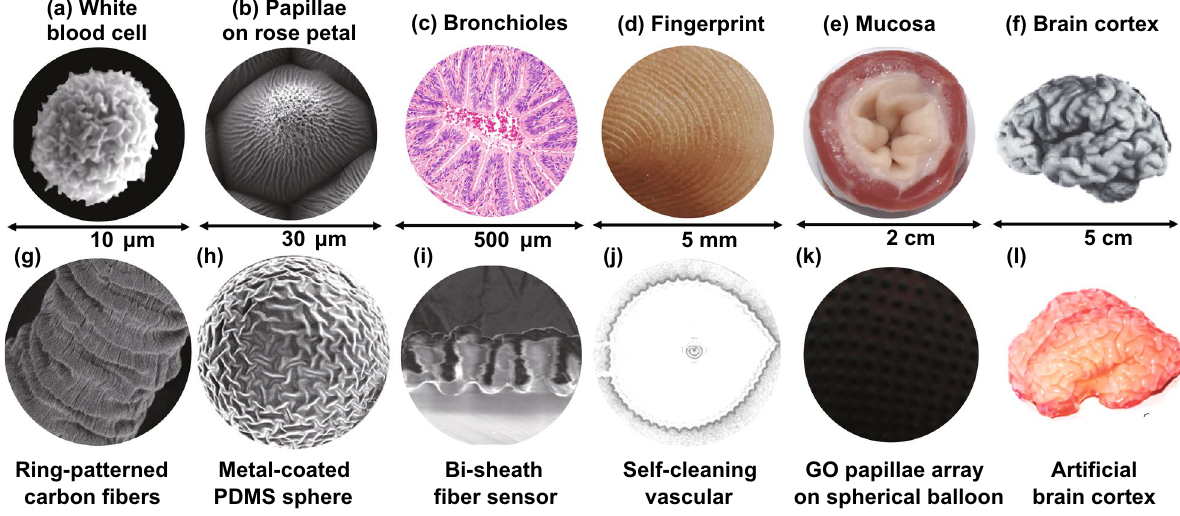
Fig. 1 Wrinkling patterns on curved substrates a – f from nature and g – l in labs across multiple length scales. a White blood cell. The extremely wrinkled membrane enables the cell to expand and contract under chemotaxis and phagocytosis [3]. Copyright 2008 Springer Nature. b Papil- lae on the rose petal. c Cross-sectional view of the bronchioles [15]. Copyright 2018 Elsevier. d Photograph of fingerprint. e Mucosa of bovine esophagus [17]. Copyright 2011 Elsevier. f Human brain [11]. Copyright 2010 Elsevier. g Ring-patterned carbon fibers [58]. Copyright 2019 Elsevier. h Metal-coated polydimethylsiloxane (PDMS) spheres for tunable frication [59]. Copyright 2019 Wiley. i Bi-sheath fiber for strain sen- sor [60]. Copyright 2017 Wiley. j Wrinkled tube for anti-thrombotic [63]. Copyright 2019 Elsevier. k Papillae array for microdroplet manipula- tion [54]. Copyright 2019 Wiley. l Swelling-induced artificial brain cortex with sulci and gyri [65]. Copyright 2016 Springer